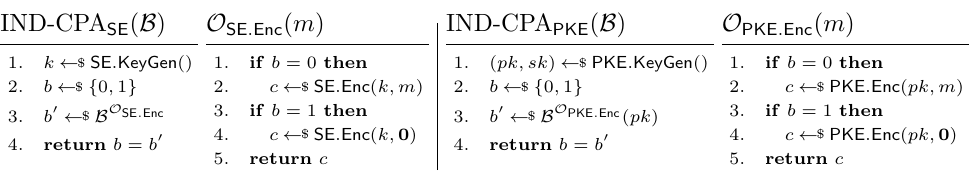
Figure 9: The IND-CPA games for (left) a symmetric encryption scheme SE and (right) a public-key encryption scheme PKE .